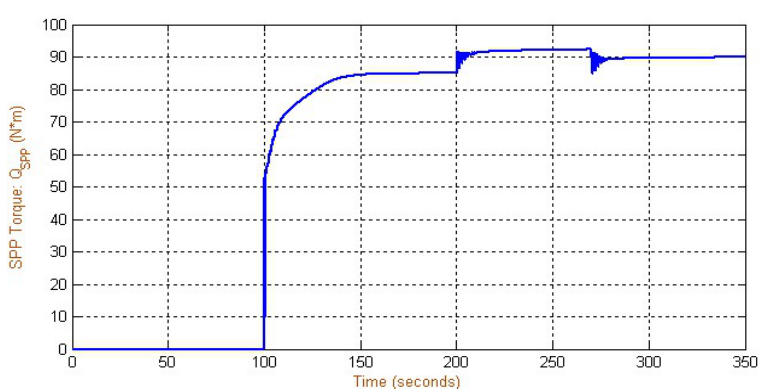
Figure 26. SPP thrust versus time.